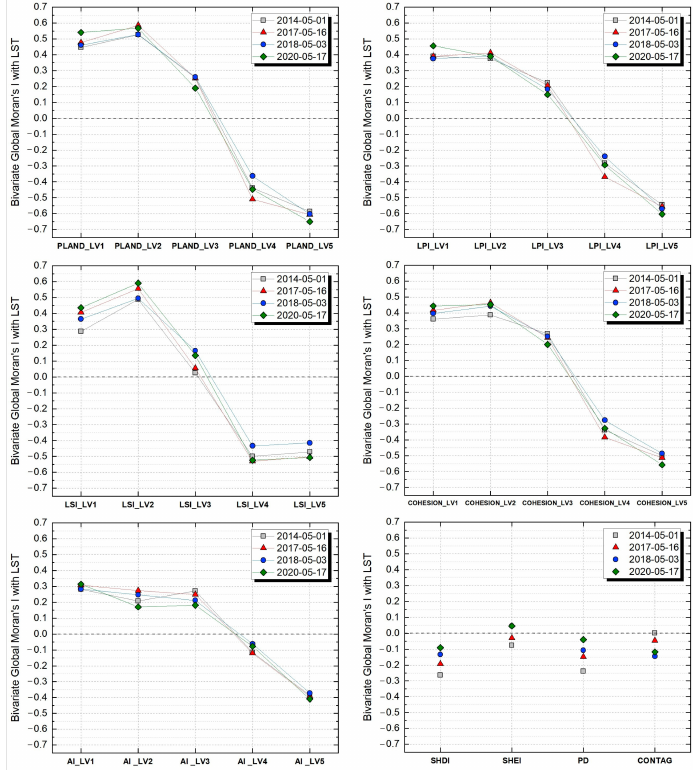
Figure 7. Bivariate global Moran’s I between landscape metrics of IPSD levels and LST (the significance levels of all Moran’s I were at p < 0.001 except for CONTAG of 1 May 2014 with p >